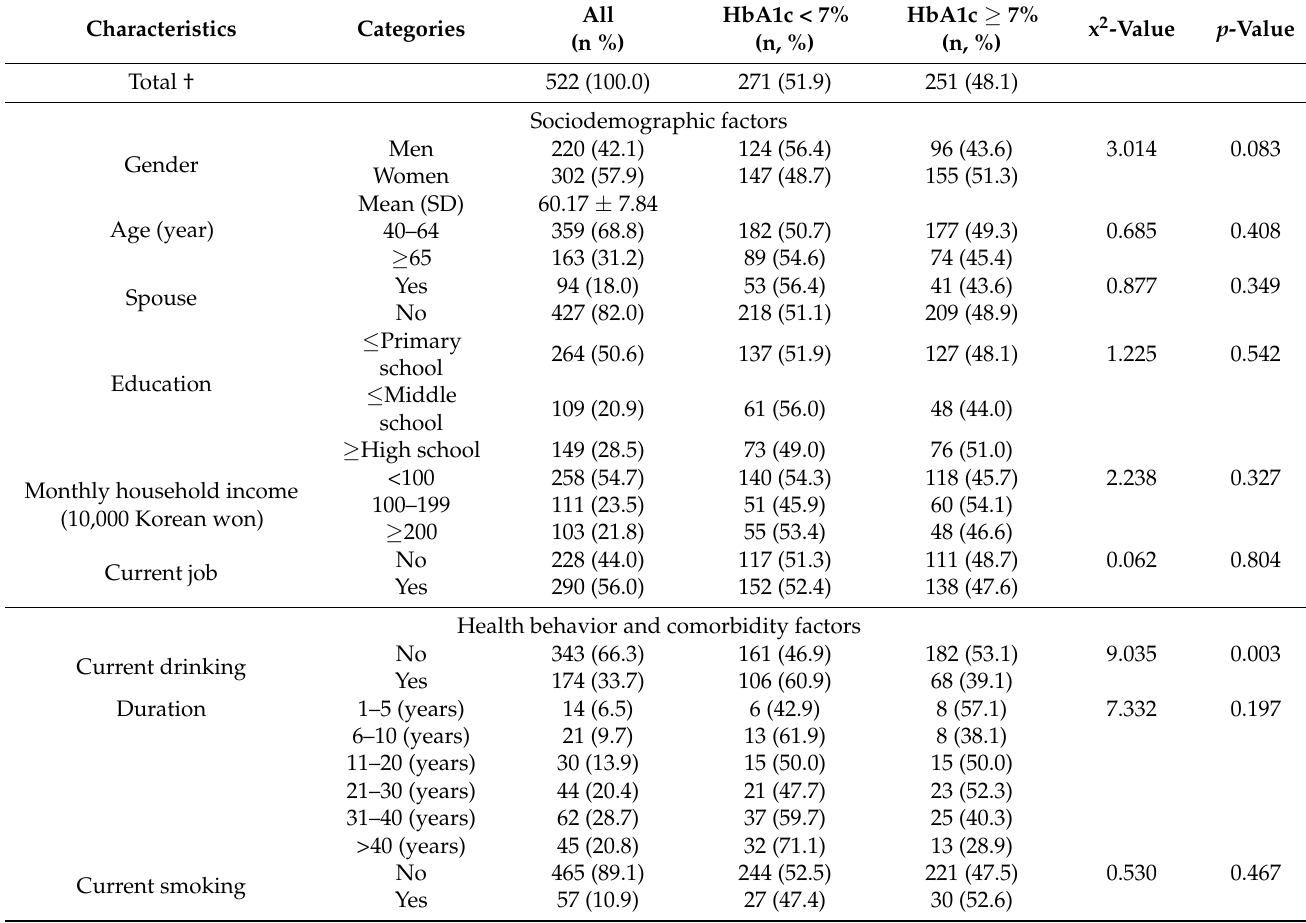
Table 1. General characteristics of the participants and differences of glycemic control according to the characteristics.